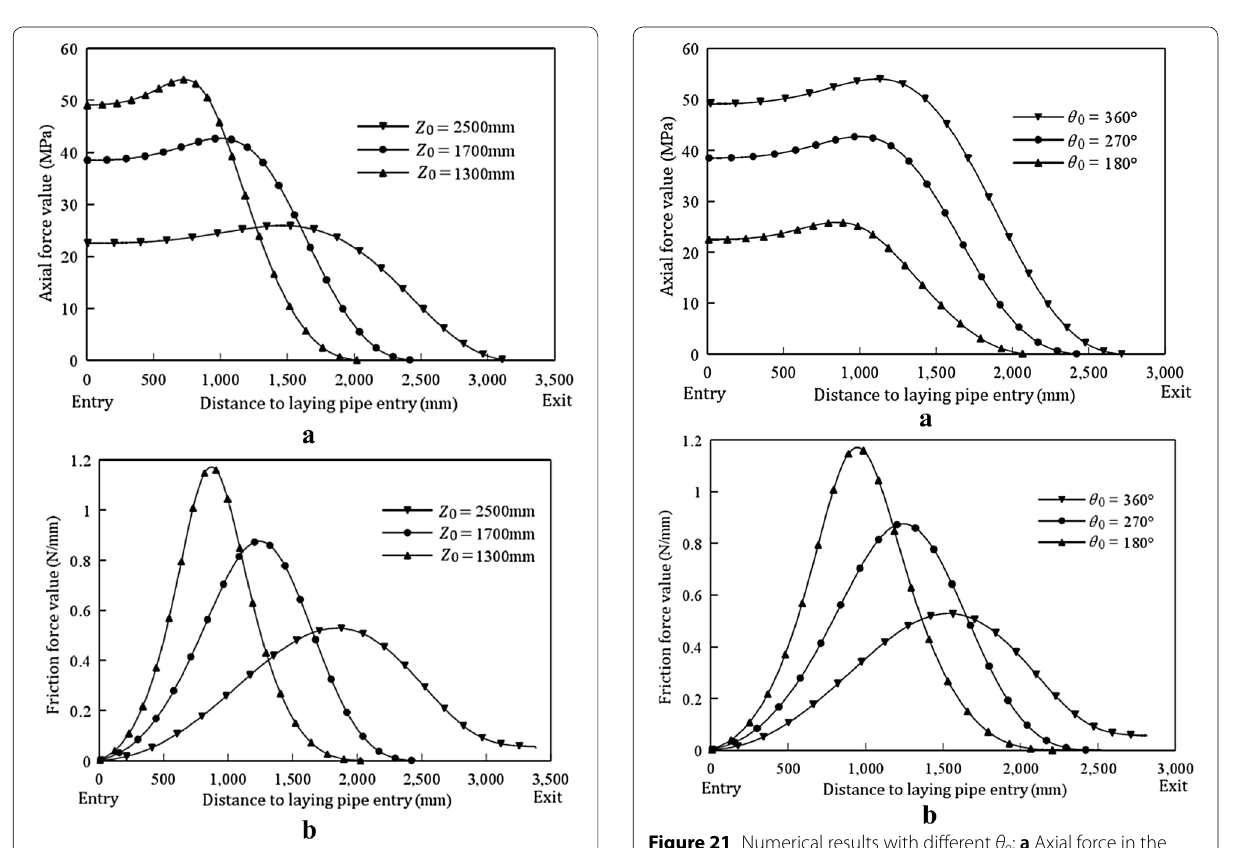
Figure 20 Numerical results with different Z 0 : a Axial force in the design laying pipe; b Friction force in the design laying pipe